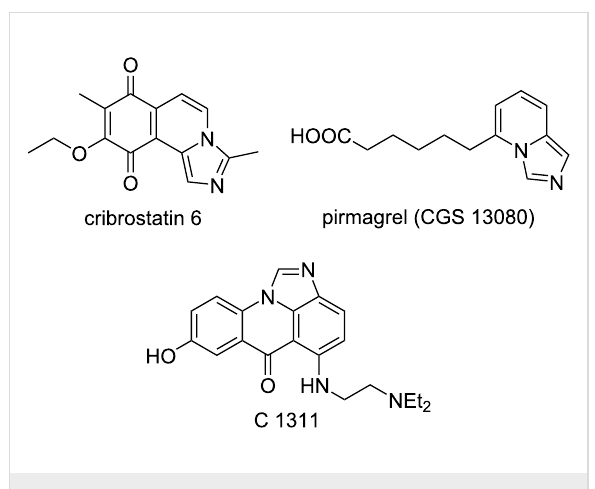
Figure 1: Biologically active imidazo[1,5- a